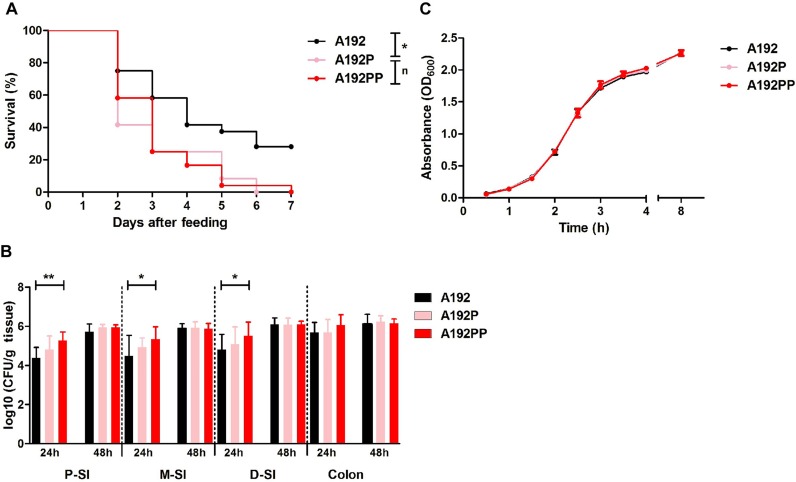
E. coli A192PP has enhanced capacity to colonize the GI tract and induce systemic infection in susceptible neonatal rats.(A) Survival of P2 rat pups fed 2–6 x 106
E. coli K1 A192, A192P or A192PP (all, n = 24). Log-rank (Mantel-Cox) test; ns, nonsignificant; *, P < 0.05; **, P < 0.01). (B) Quantification of viable E. coli K1 in intestinal sections: tissues were removed 24 or 48 h after feeding, and CFU/g tissue determined by plating onto MacConkey agar. E. coli K1 colonies were identified with K1-specific phage. At 24 h, strain A192 n = 11, strain A192P n = 12, strain A192PP n = 12. At 48 hours, strain A192 n = 12, strain A192P n = 11, strain A192PP n = 11; Student's t test; *, P < 0.05; **, P < 0.01. (C) Growth of E. coli strains A192, A192P and A192PP in Mueller-Hinton (MH) broth at 37°C (200 orbits/min) (±SD, n = 3).